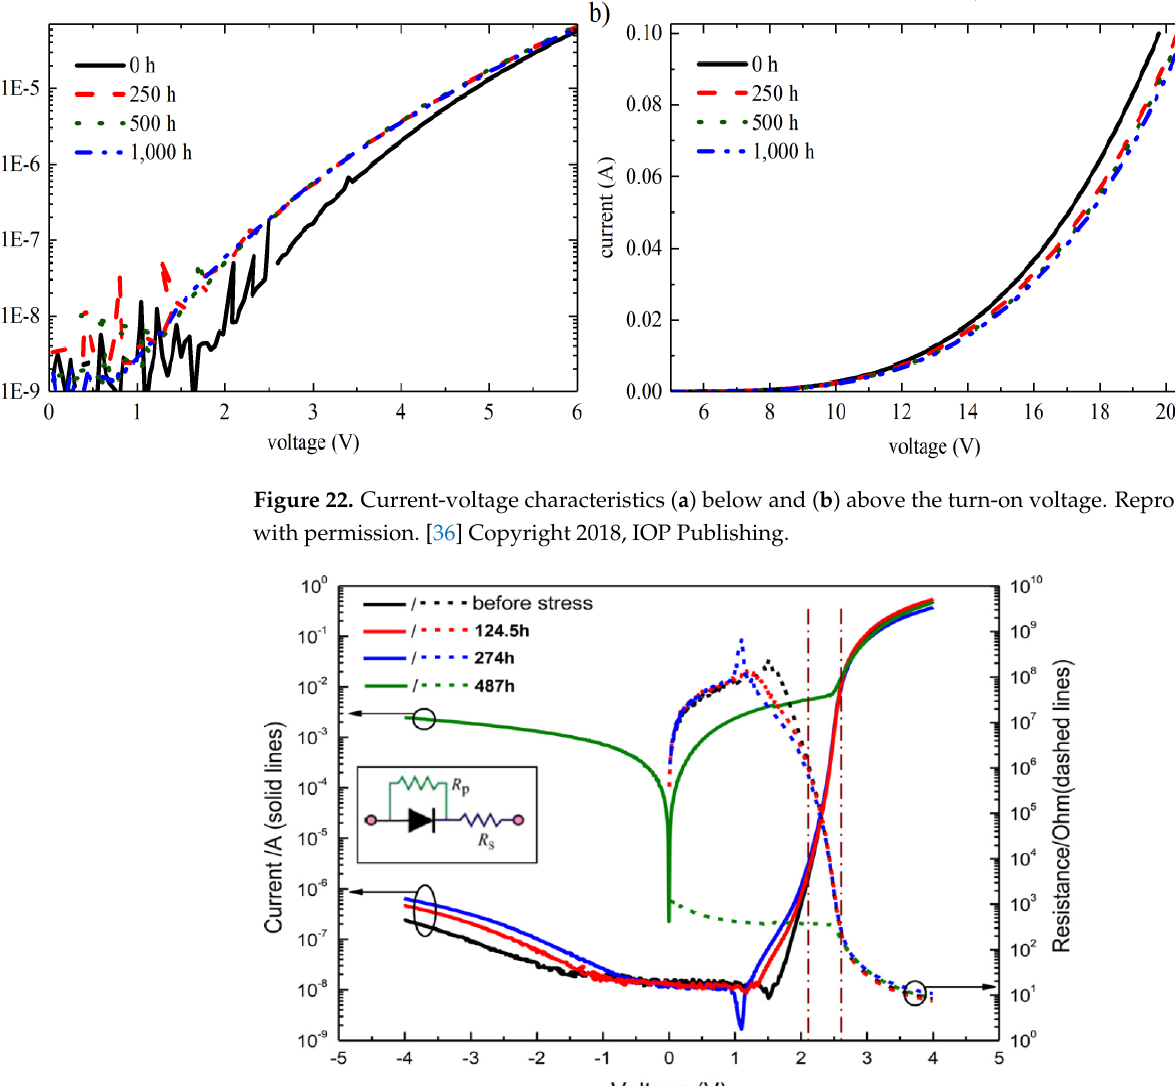
Figure 23. I-V curves and resistance characteristics of an LED: before stress, and 124.5, 274, and 487 h after stress. Reproduced with permission. [57] Copyright 2012, AIP.